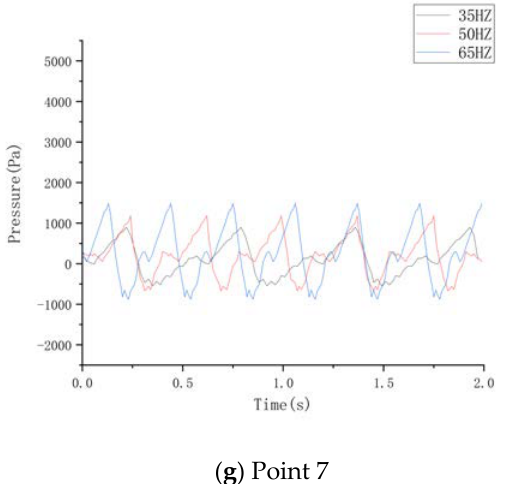
Figure 16. Pressure pulsation of the monitoring point under different speeds when the outlet pressure is 0 MPa.